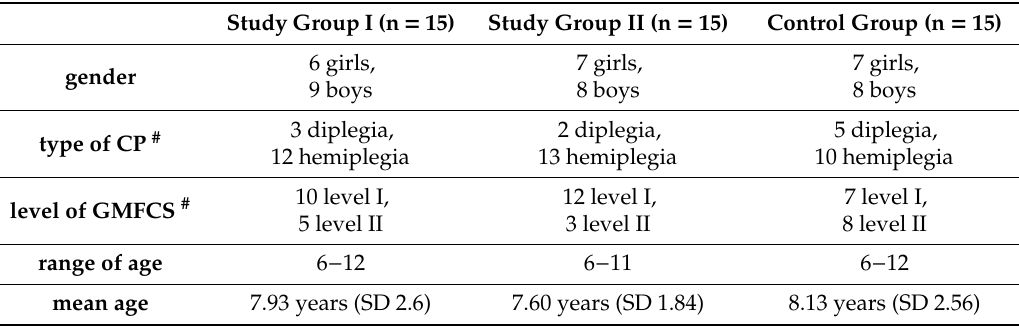
Table 1. Characteristics of the study